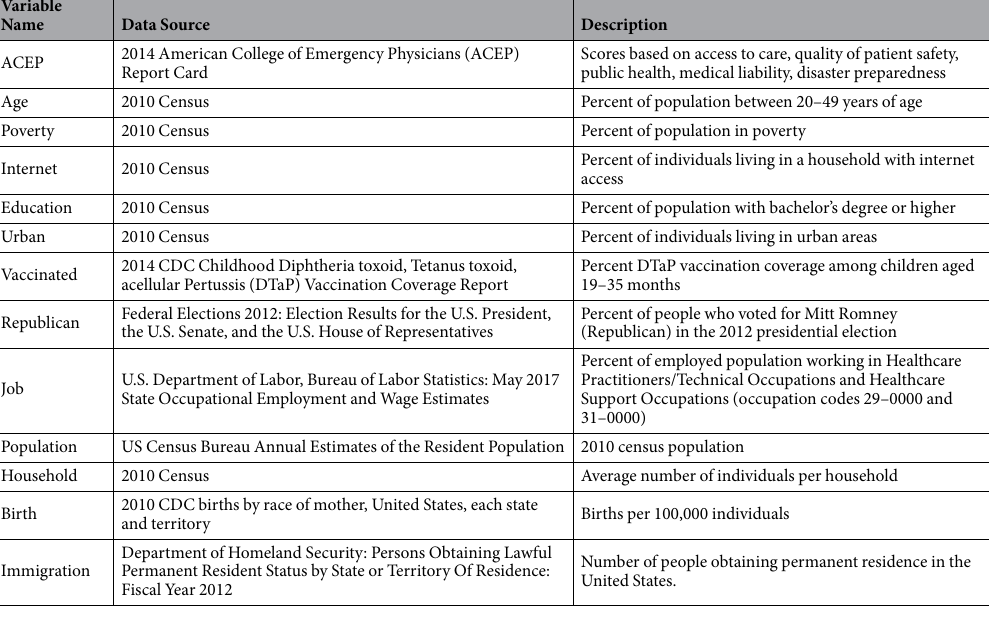
Table 2. The states’ sociodemographic abbreviated variable names, data sources, and descriptions used in the explanatory linear